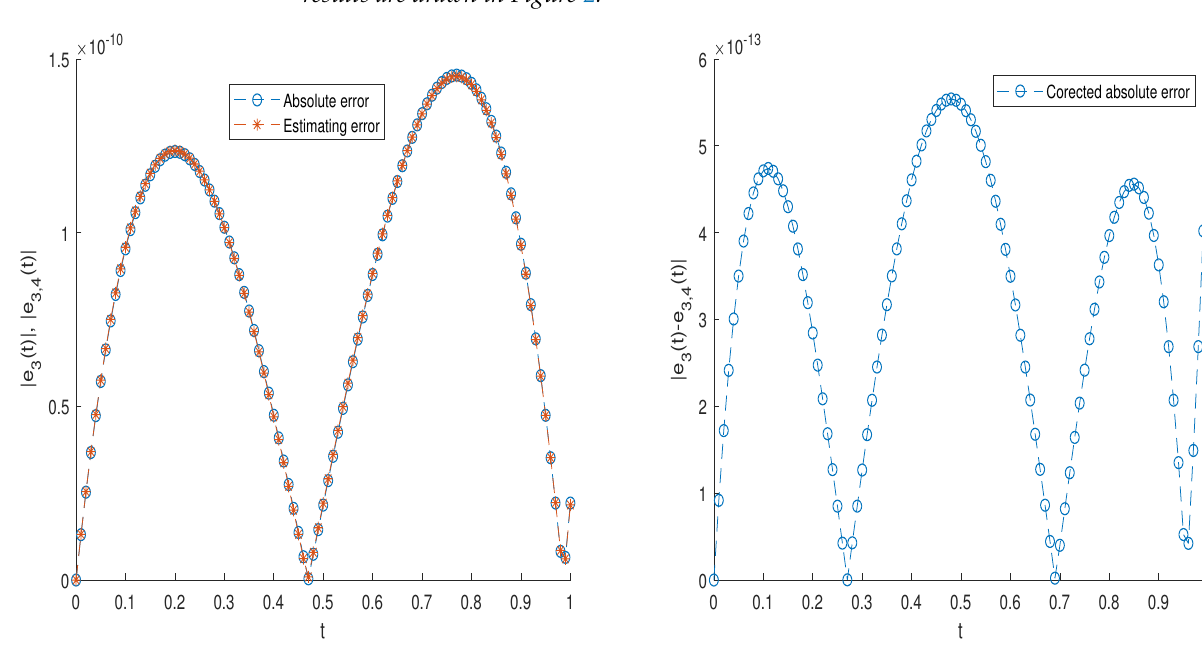
Figure 2. The error with its estimation by the procedure and the corrected error for Example 2 and ( N , M ) = ( 3,4 ) .